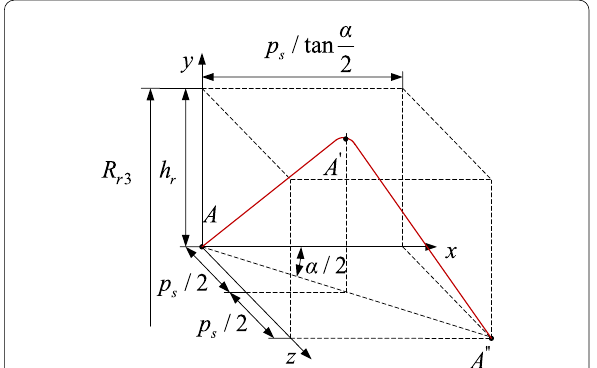
As shown in Figure 4, point A is the center point of the roller, so R r 3 can be expressed as: